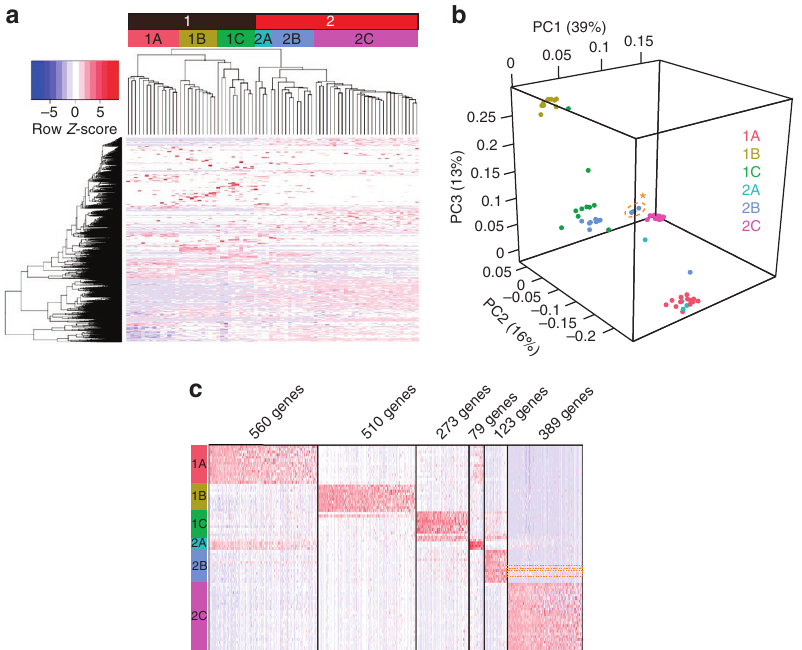
Figure 2 | scRNA-seq analysis of Prdm1 þ placental cell populations demonstrate transcriptional profiles characteristic of distinct cell lineages. ( a ) Hierarchical clustering of scRNA-seq data from 78 samples identifies two groups (1 and 2) with three clear subdivisions, totalling six molecularly distinct populations (1A–C and 2A–C). Colour coded header bars indicate the given identifier for each group. ( b ) PCA of significantly variable genes on the basis of linear dimensional reduction revealing key relationships between groups. ( c ) Heatmap of genes significantly enriched within each individual group ( t -test; P r 1 (cid:2) 10 (cid:3) 3 ). Group 2B cells expressing endothelial markers are outlined in